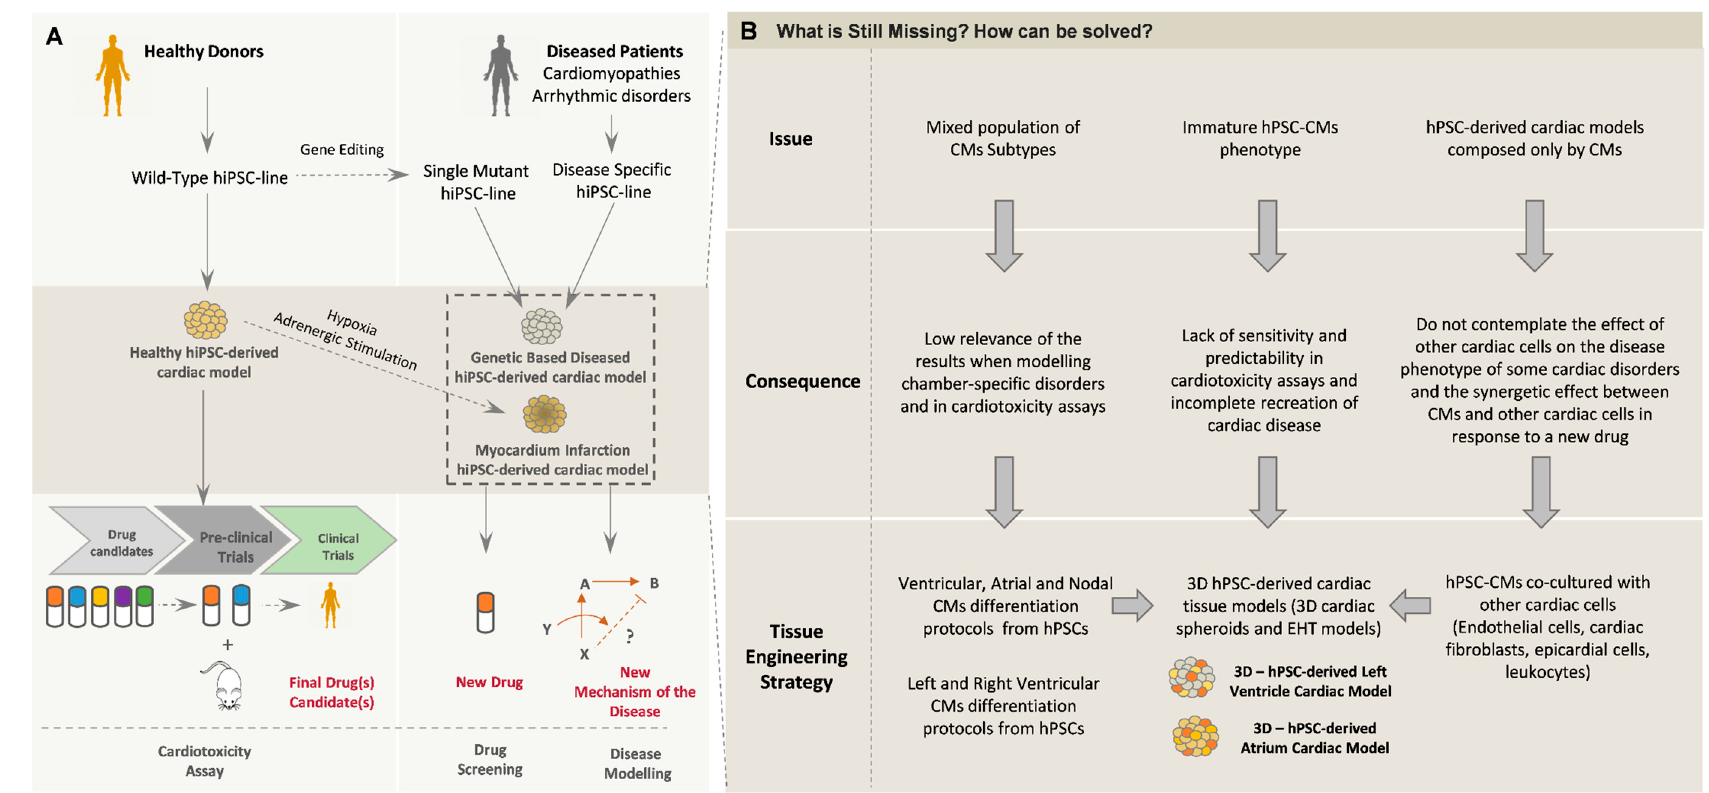
Figure 5. hiPSC-derived 3D cardiac models—applications and challenges. ( A ) hPSCs, and specifically hiPSCs, are a powerful technology to generate wild-type and patient-specific cardiac models to be applied in drug screening, cardiotoxicity tests and disease modeling assays. ( B ) The most widely used cardiac models for in vitro applications still present some limitations that can be solved by using different tissue engineering strategies.